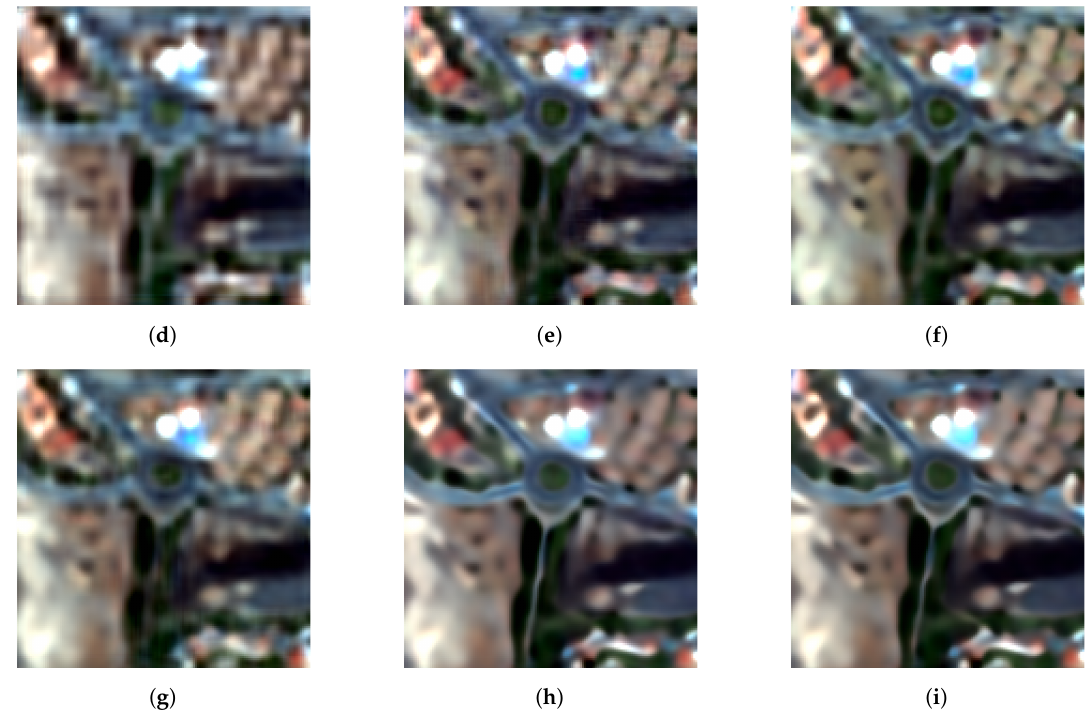
Figure 13. Results of a region of Maspalomas 2015 from the W-S Set1. ( a ) HR, ( b ) LR with NN interpolation, ( c ) LR with bicubic interpolation, ( d ) SR convolutional neural network (SRCNN), ( e ) EDSR, ( f ) RCAN, ( g ) SRGAN with α = 0, ( h ) RS-Enhanced Super-Resolution Generative Adversarial